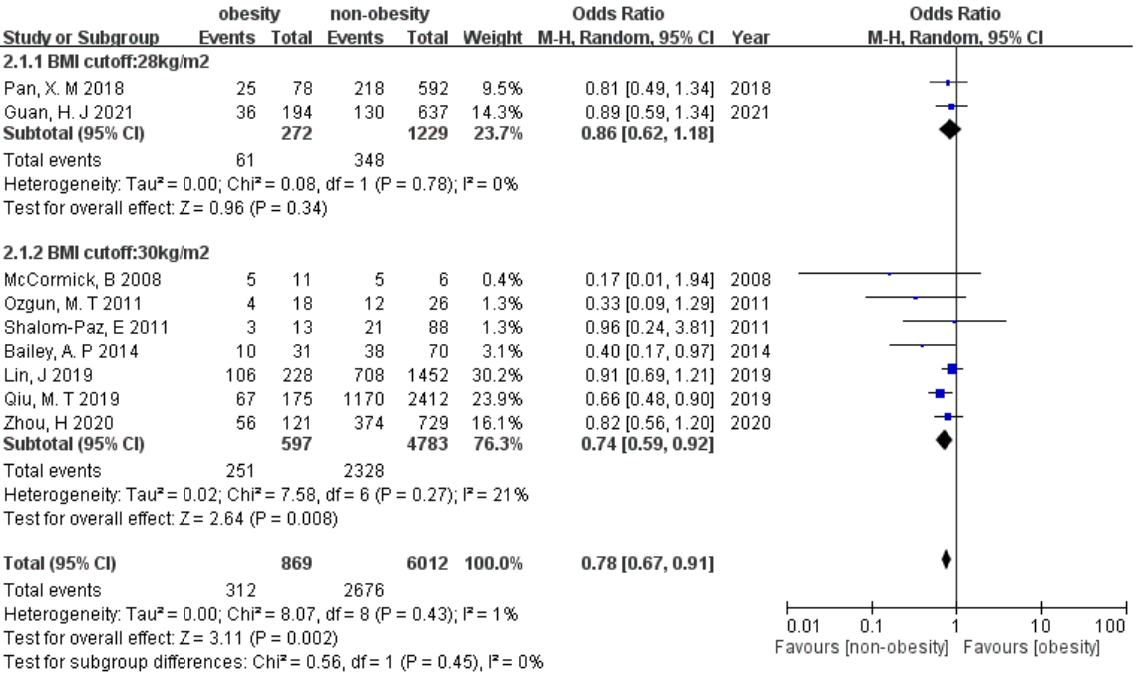
Figure 5. Forest plot of the association between live birth and obesity in women with PCOS.